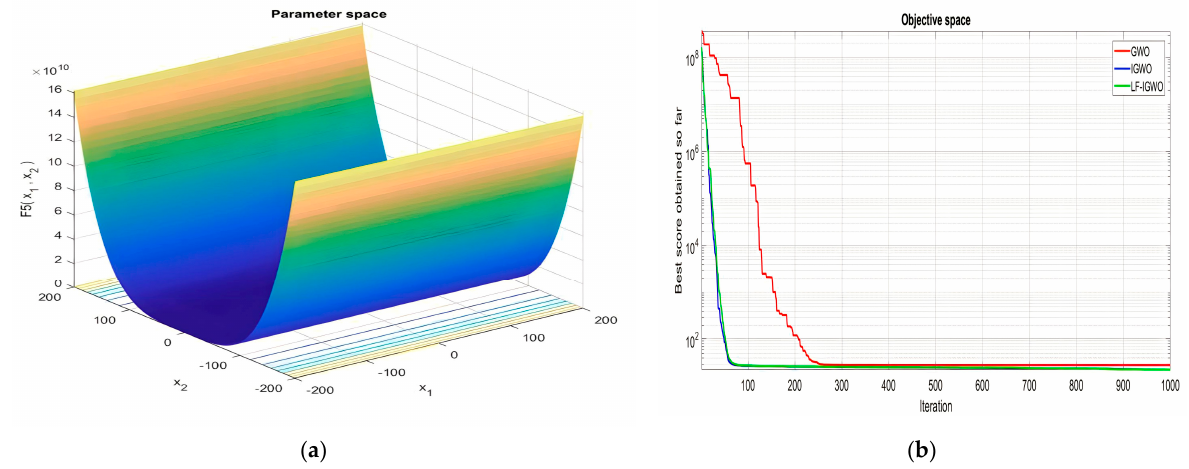
Figure 7. ( a ) Search space for unimodel function F05 ( b ) Comparison of convergence curve for F05.